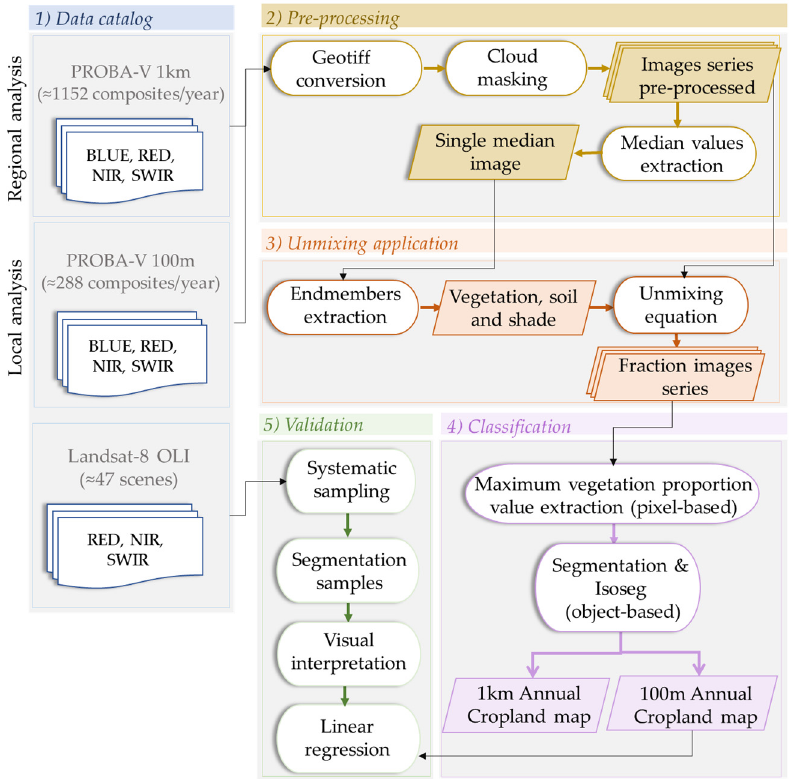
Figure 4. General methodological flowchart for annual cropland classification and evaluation.